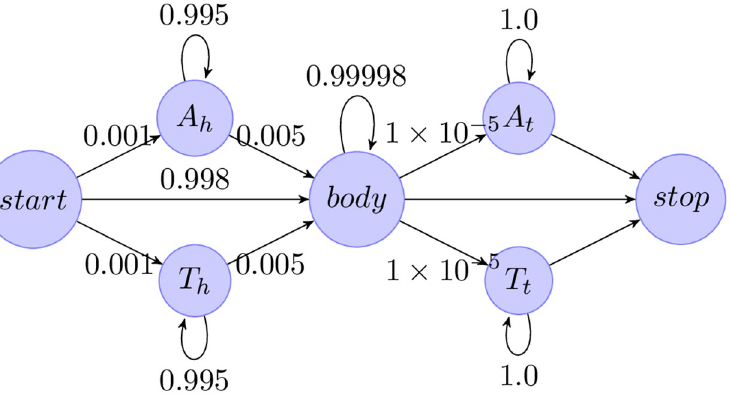
Fig 3. Hidden Markov model used for trimming poly-A and poly-T heads and tails. A head and tail states have a small ( p = 0.01) probability to emit non-A bases, and similarly for T . The body state emits all four bases with equal probability. The start , and stop states emit